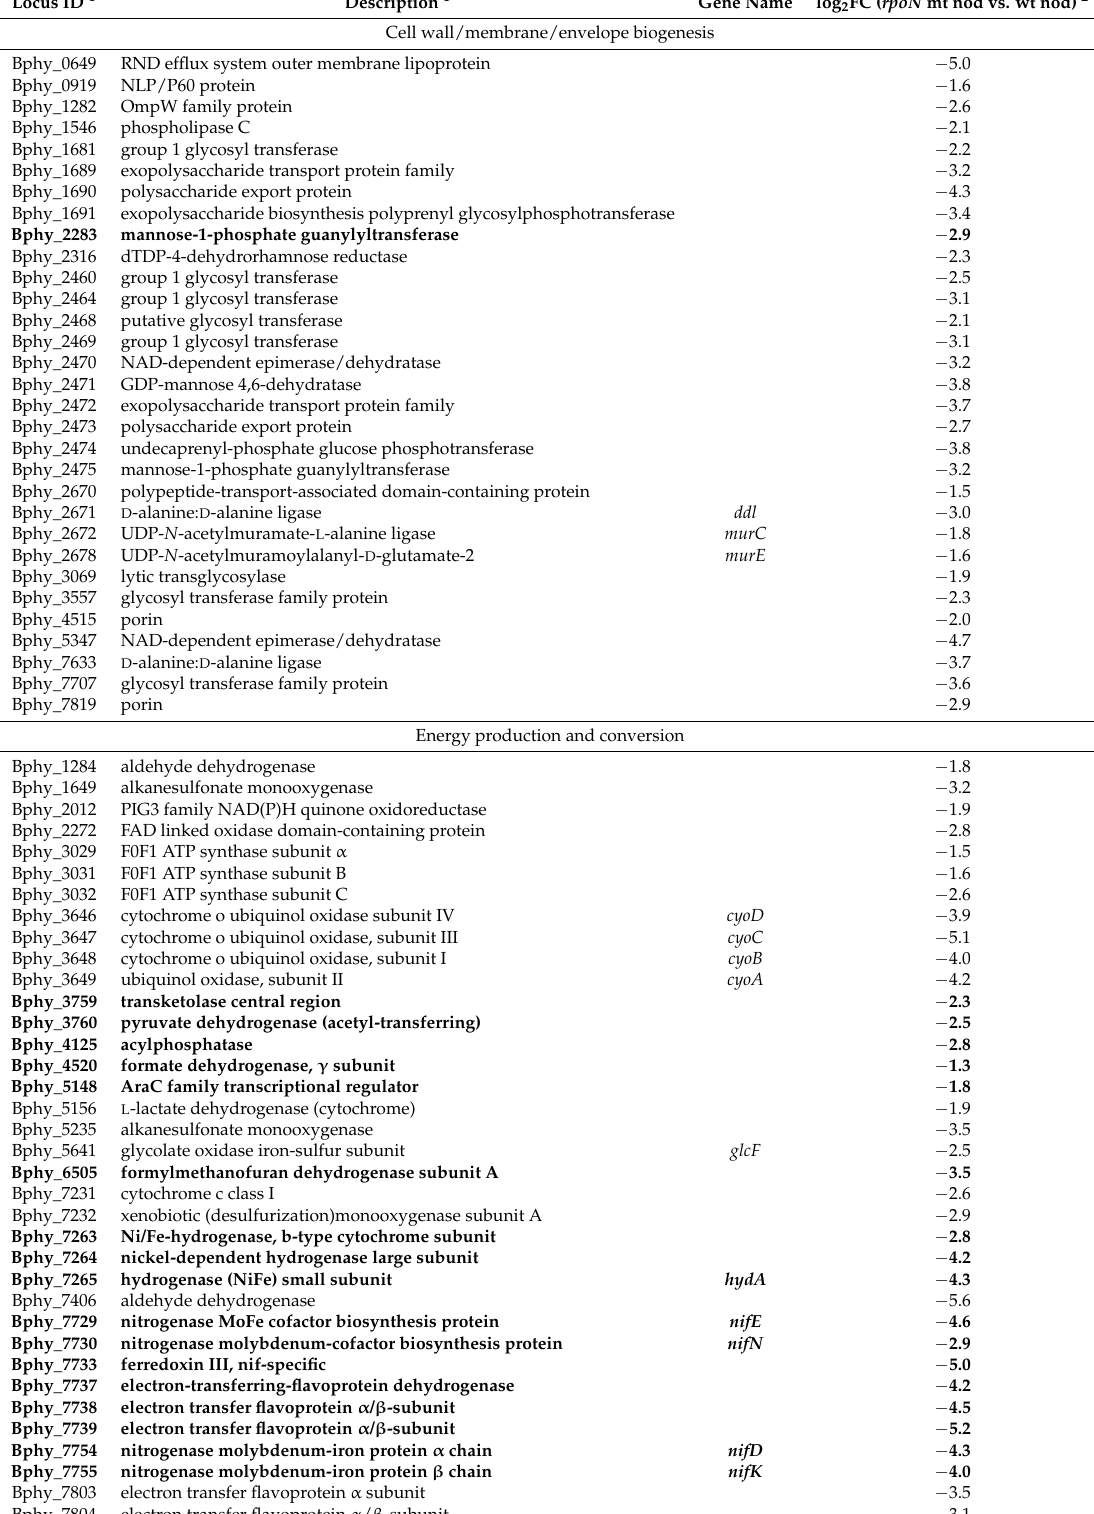
Table 3. List of 93 genes positively controlled by RpoN and belonging to an over-represented eggNOG category (Fischer test, p -value < 0.01). Genes harboring a putative RpoN-box in their promoter region are shown in